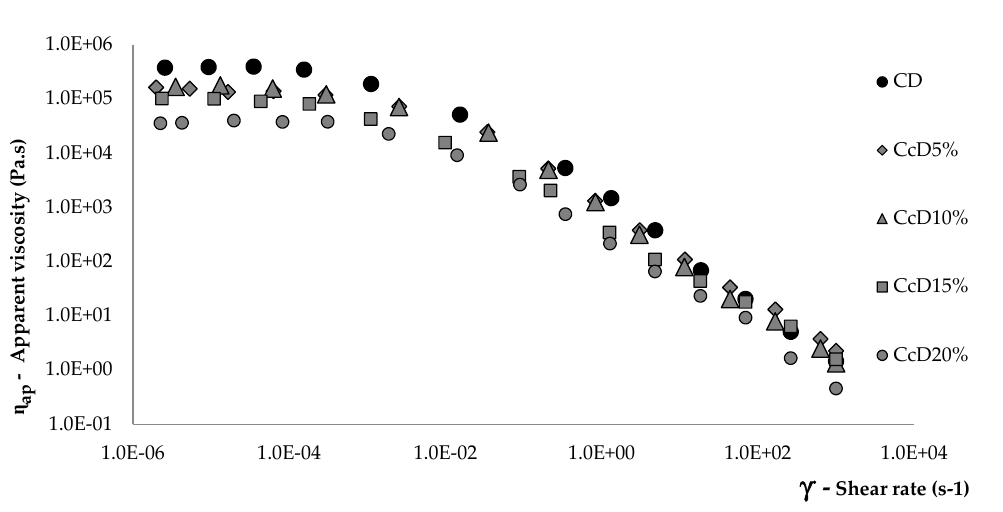
Figure 1. Flow rheology behavior of the control dough (CD) and Cc doughs (CcD): 5% up to 20%, w / w .